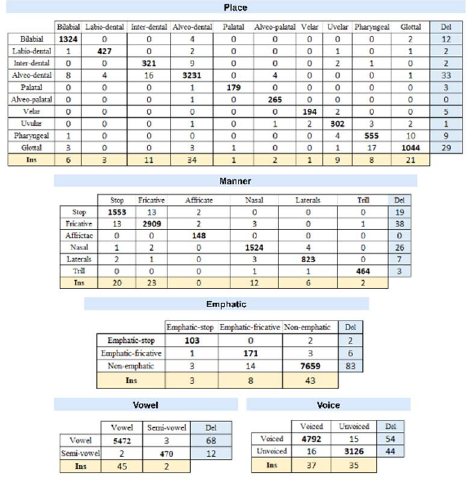
Figure 8. Confusion matrix of each of the AF categories using our best model: MDD-object-G- Large/NS.